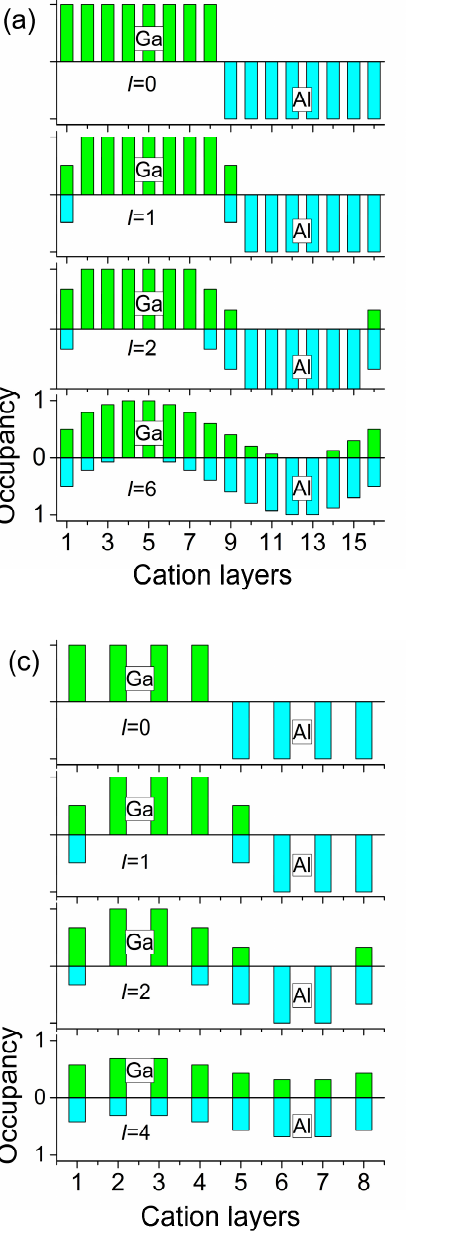
Figure 6. Cation concentration profiles of (GaN) m /(AlN) m SLs with different degree of interface diffusion: ( a ) m = 8, ( c ) m = 4. Calculated 𝑧(𝑥𝑥)𝑧̅ Raman spectra of (GaN) m /(AlN) m SLs (blue lines) and frequency distribution of A 1 (LO) modes (red lines): ( b ) m = 8, ( d ) m = 4.